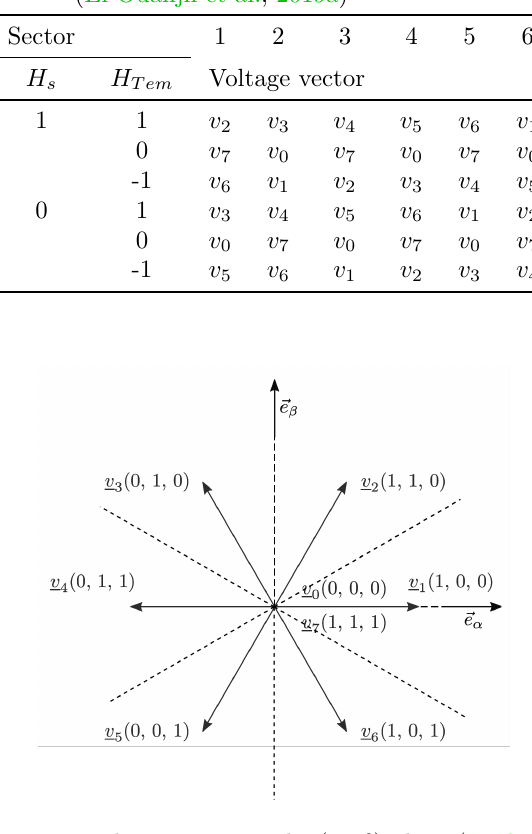
Table 1: Switching table of a classic DTC drive